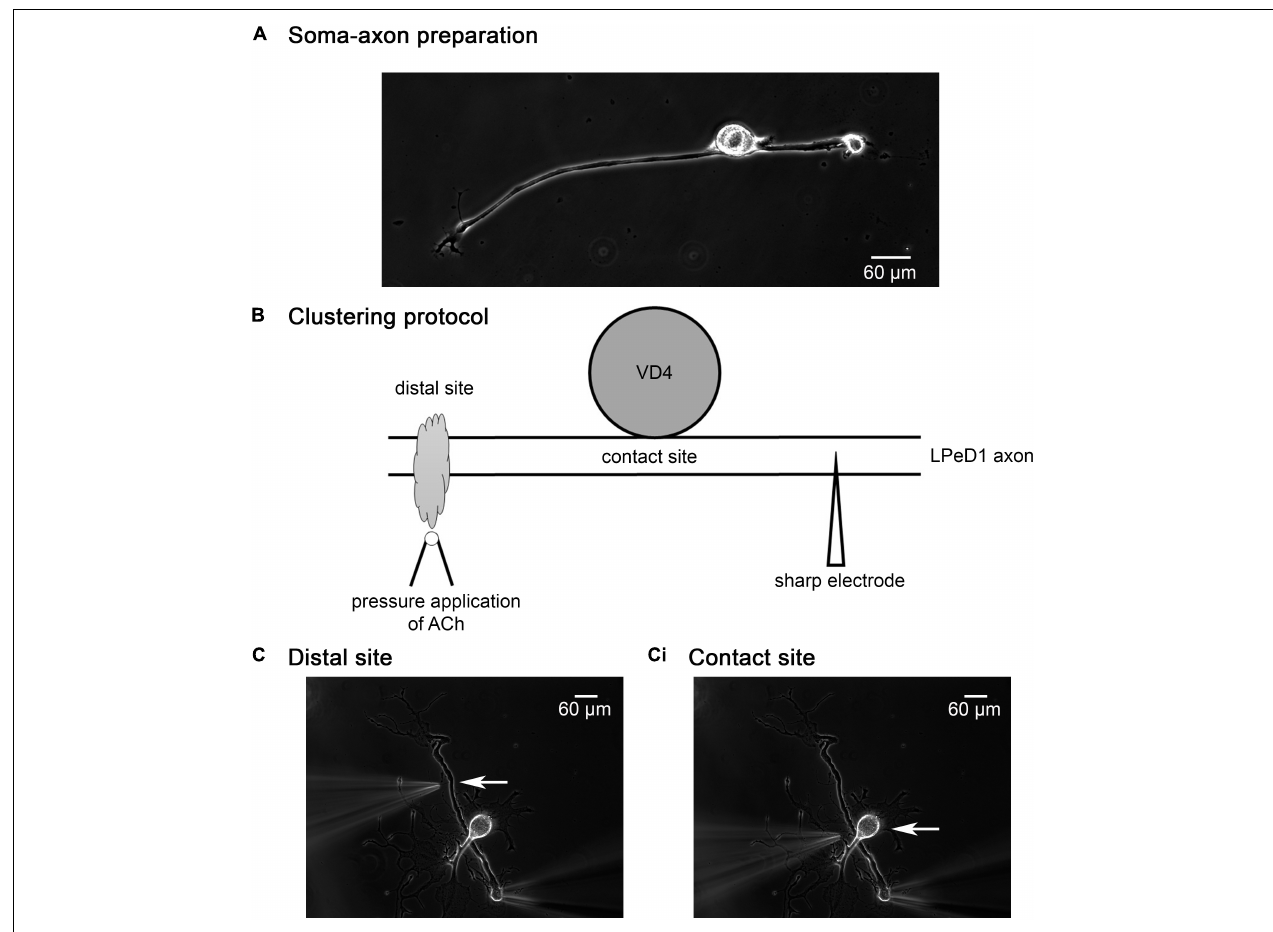
FIGURE 5 | Protocol used to investigate the functional clustering of nicotinic acetylcholine receptors (nAChRs) in visceral dorsal 4 (VD4)–left pedal dorsal 1 (LPeD1) soma–axon pairs. (A) Experimental preparation. Phase contrast image of a VD4–LPeD1 soma–axon pair (10 × magnification). (B) Diagrammatic representation of the electrophysiological protocol used to investigate the clustering of nAChRs in LPeD1 axons. LPeD1 axons were impaled with an intracellular electrode to record the response to acetylcholine (ACh) (10 − 6 M), which was simultaneously applied at either extrasynaptic (distal) or synaptic contact sites. (C) Phase contrast image of ACh being pressure applied to one of the distal sites (white arrow) on an LPeD1 axon (20 × magnification). (Ci) Phase contrast image of ACh being pressure applied to the synaptic contact site (white arrow) between the VD4 soma and LPeD1 axon (20 ×